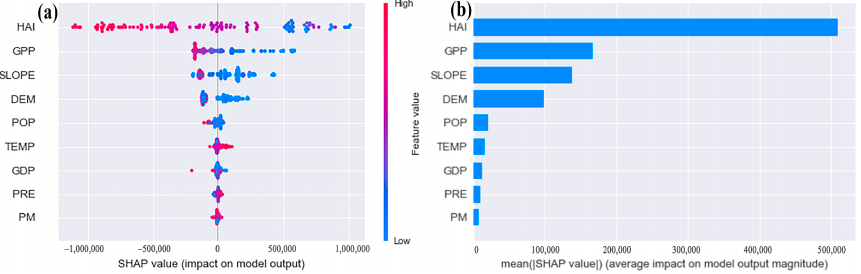
Figure 6. SHAP summary ( a ) and relative importance of each feature ( b ) of the XGBoost model of the Dongting Lake in 2000, 2005, 2010 and 2018.